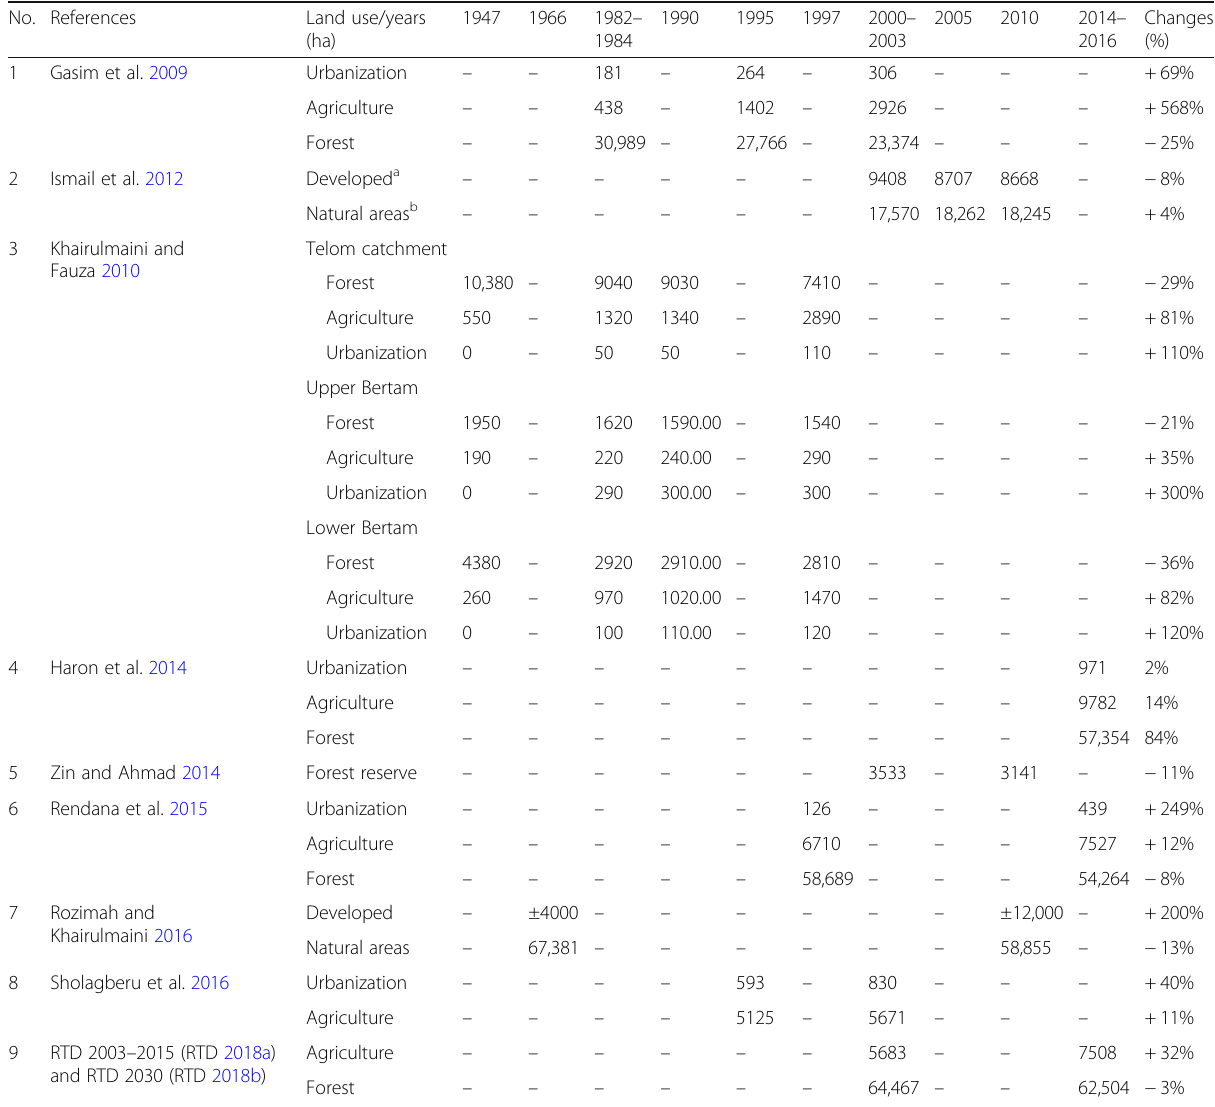
Table 1 Percentage of land use/land change (LULC) from previous